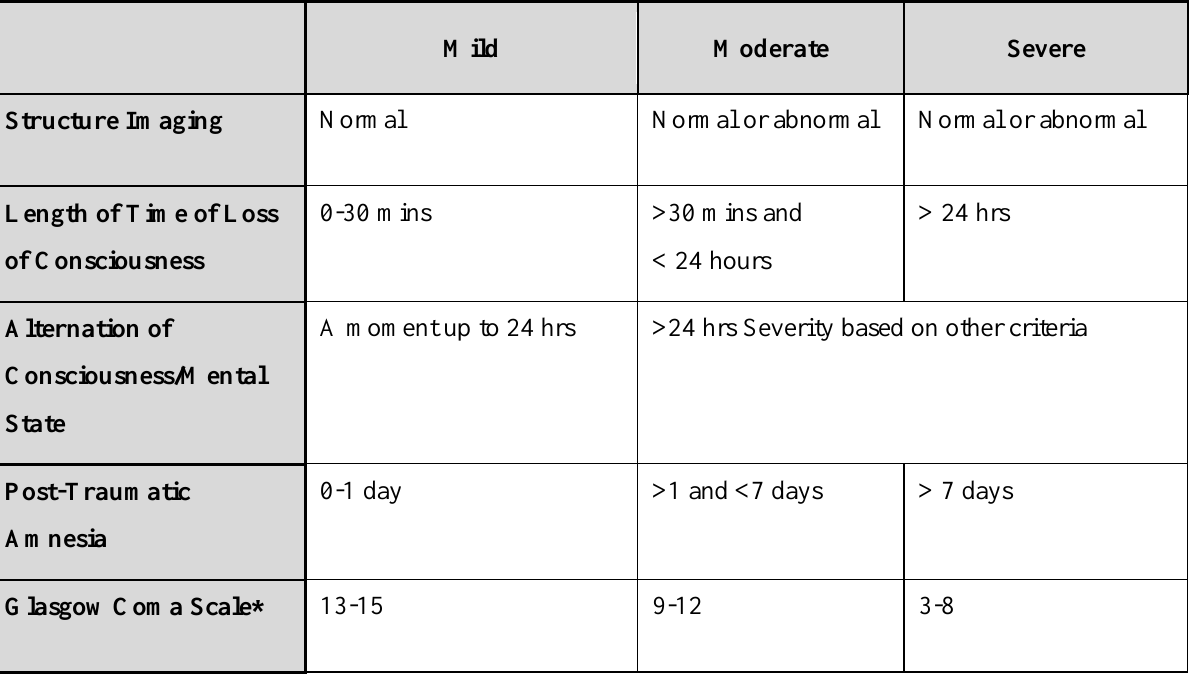
Table 2. DoD/VA Severity Stratification for Non-penetrating